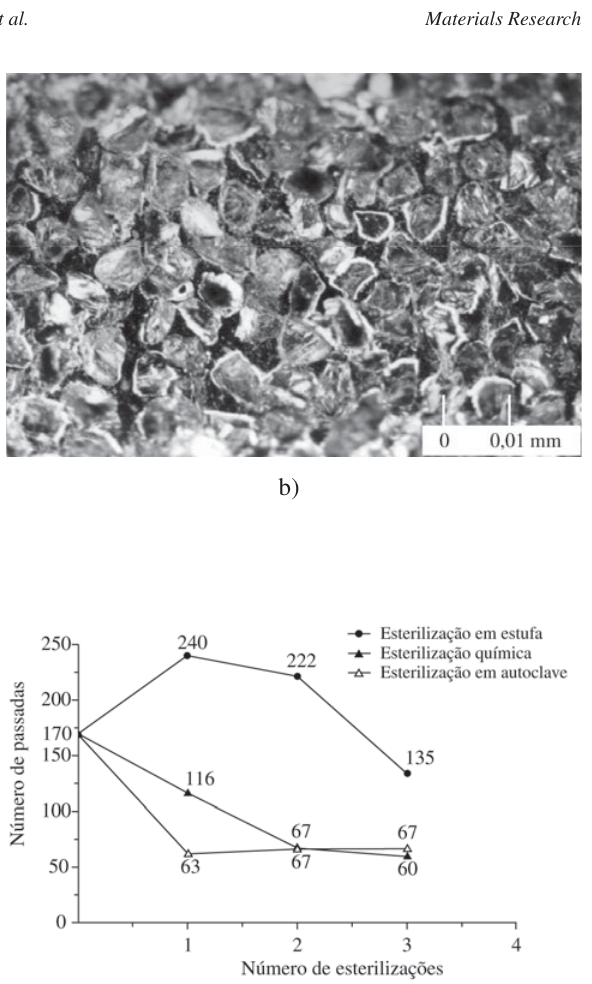
Figura 4. Número médio de passadas obtidas para as pontas dia- mantadas ensaiadas, em função do tipo e número de esterilizações